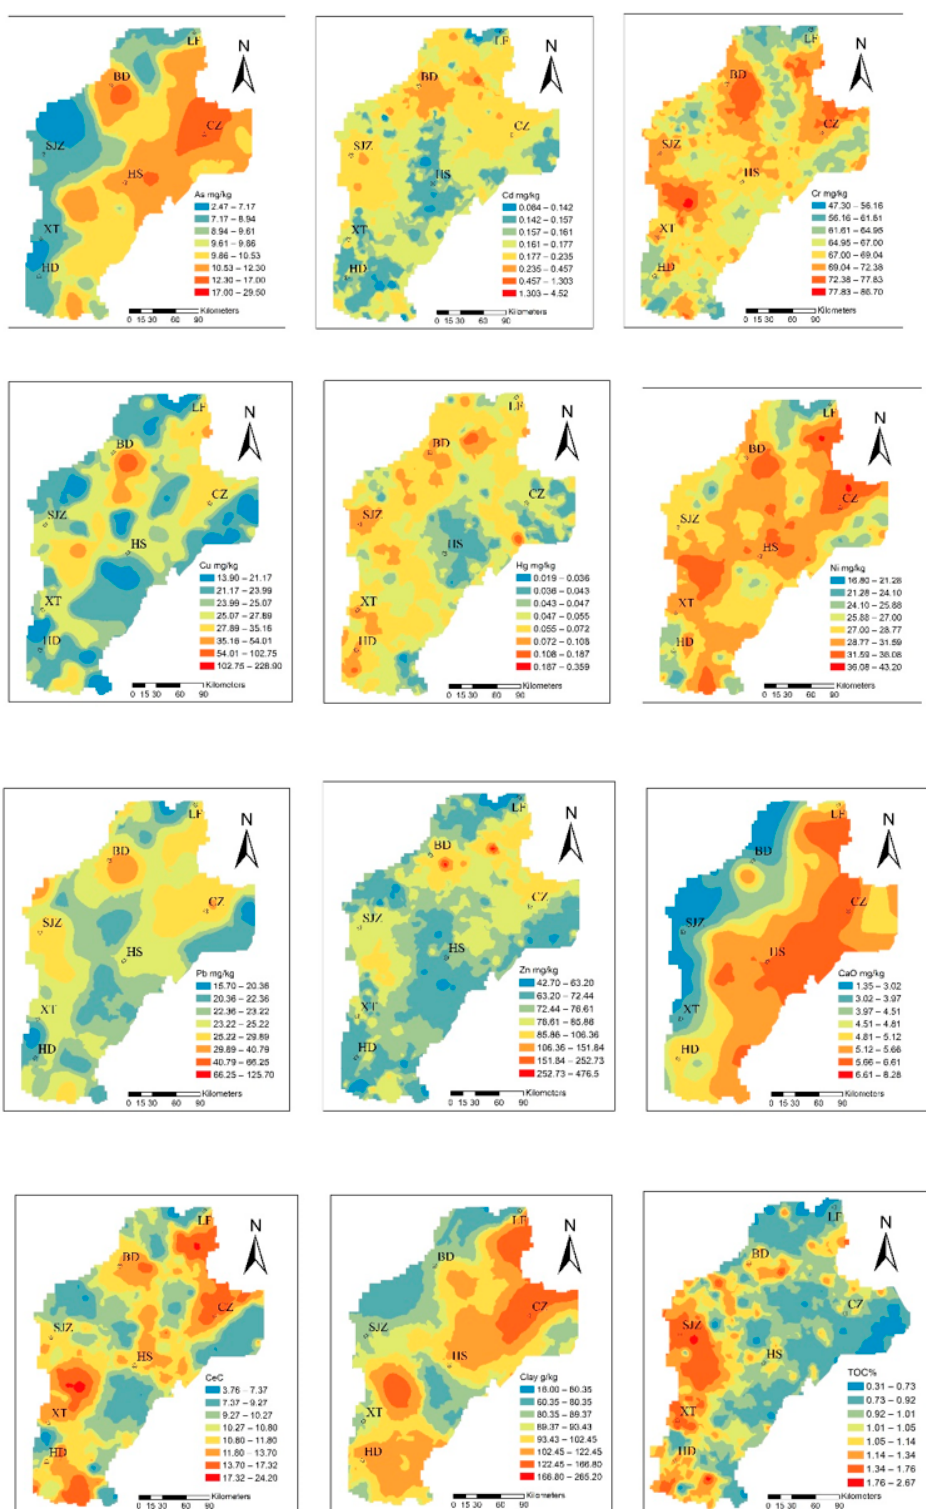
Figure 3. The distribution of metal(loid)s and soil properties.